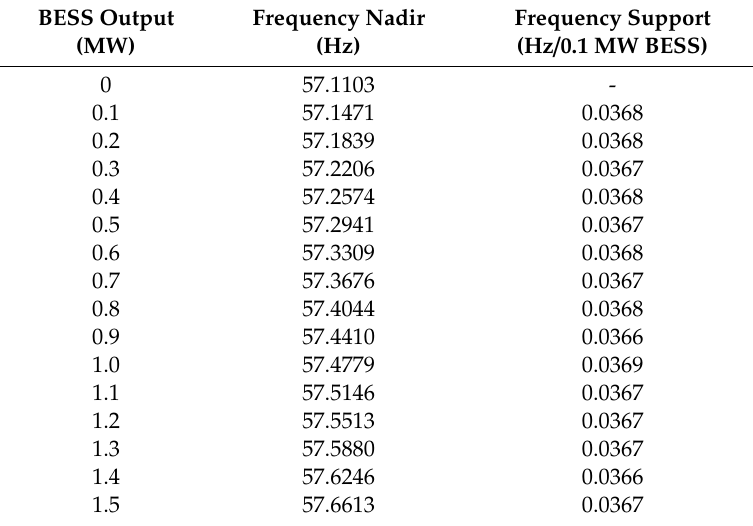
Table 1. The frequency support capability of BESS—case study.